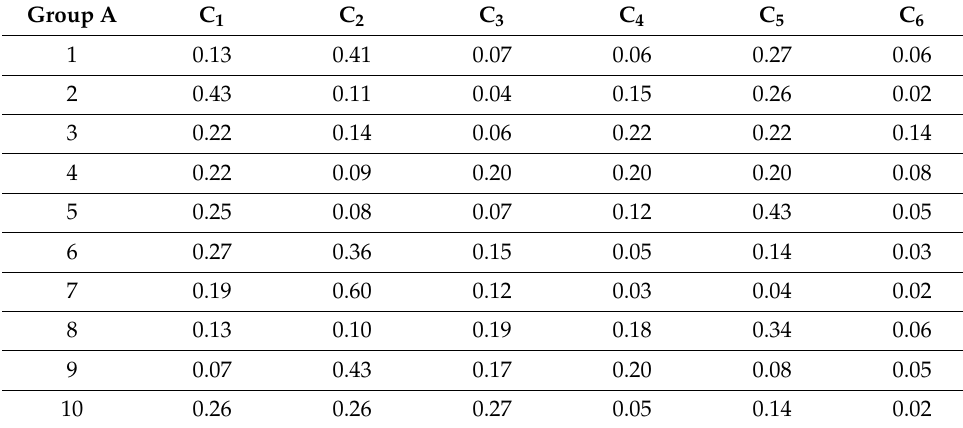
Table A1. Individual priorities for each participant in group